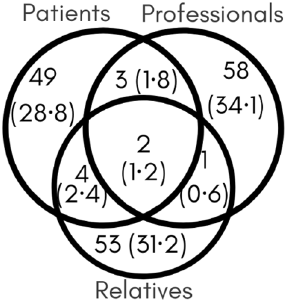
Figure 1. Percentage of each user category based on the survey criteria for classifying patients, relatives of patients and health care staff who treated patients with COVID. Number of users and percentage in